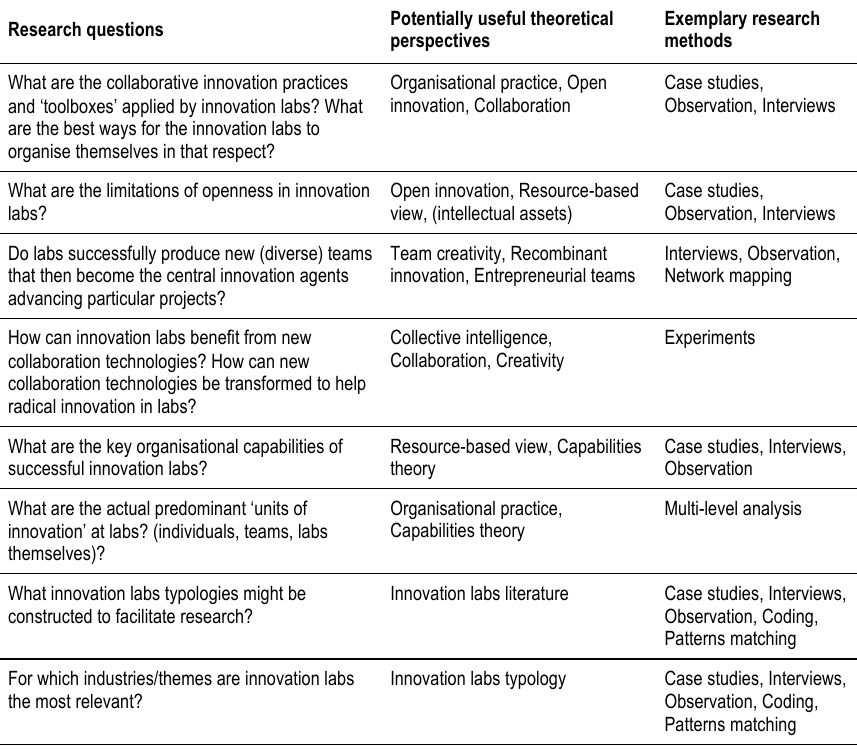
Table 2. Promising research directions and guidelines for future work in innovation labs